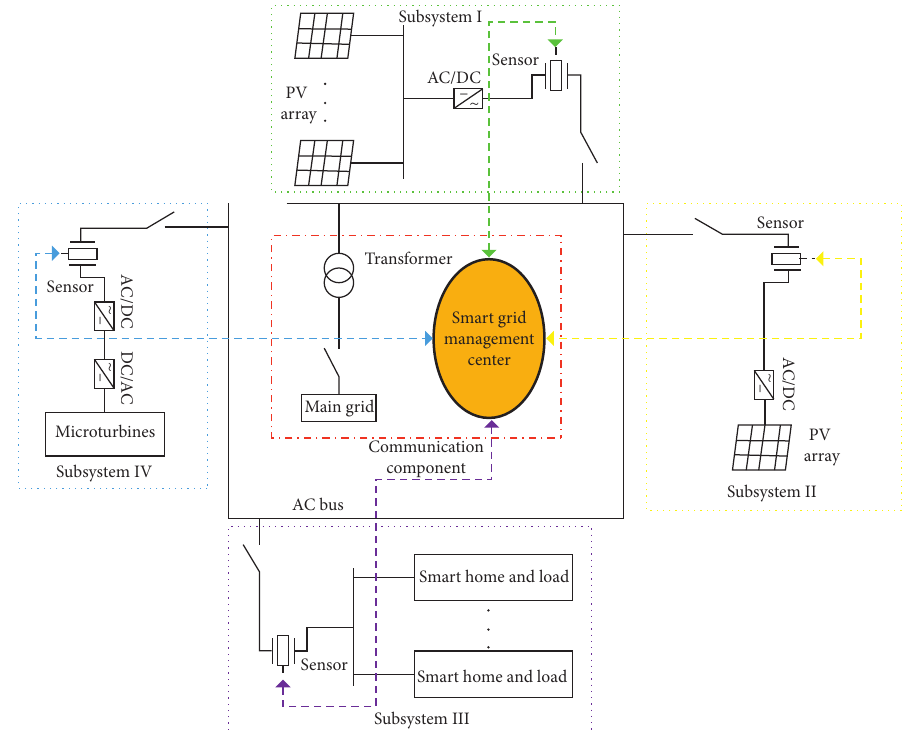
Figure 4: The benchmark power system considered in this paper.